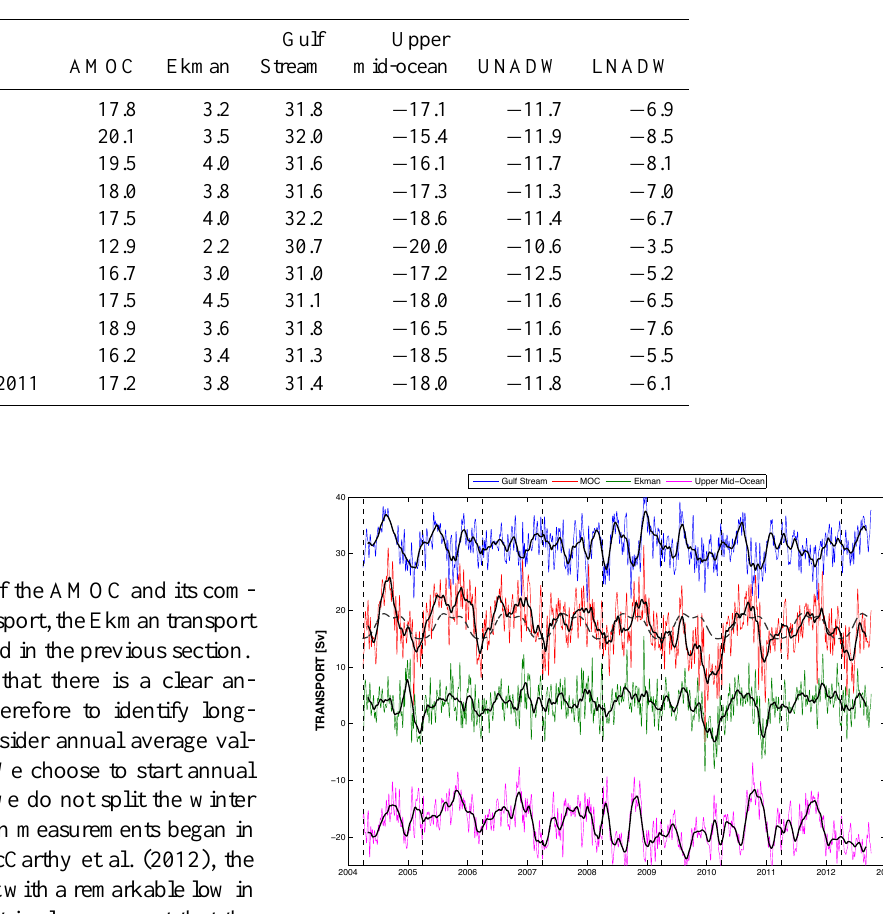
Fig. 2. Ten-day (colours) and three month low-pass (black) time se- ries of Gulf Stream transport (blue), Ekman transport (green), upper mid-ocean transport (magenta), and overturning transport (red) for the period 1 April 2004 to 1 October 2012. A dashed black line shows the mean annual cycle for the AMOC. Positive transports correspond to northward